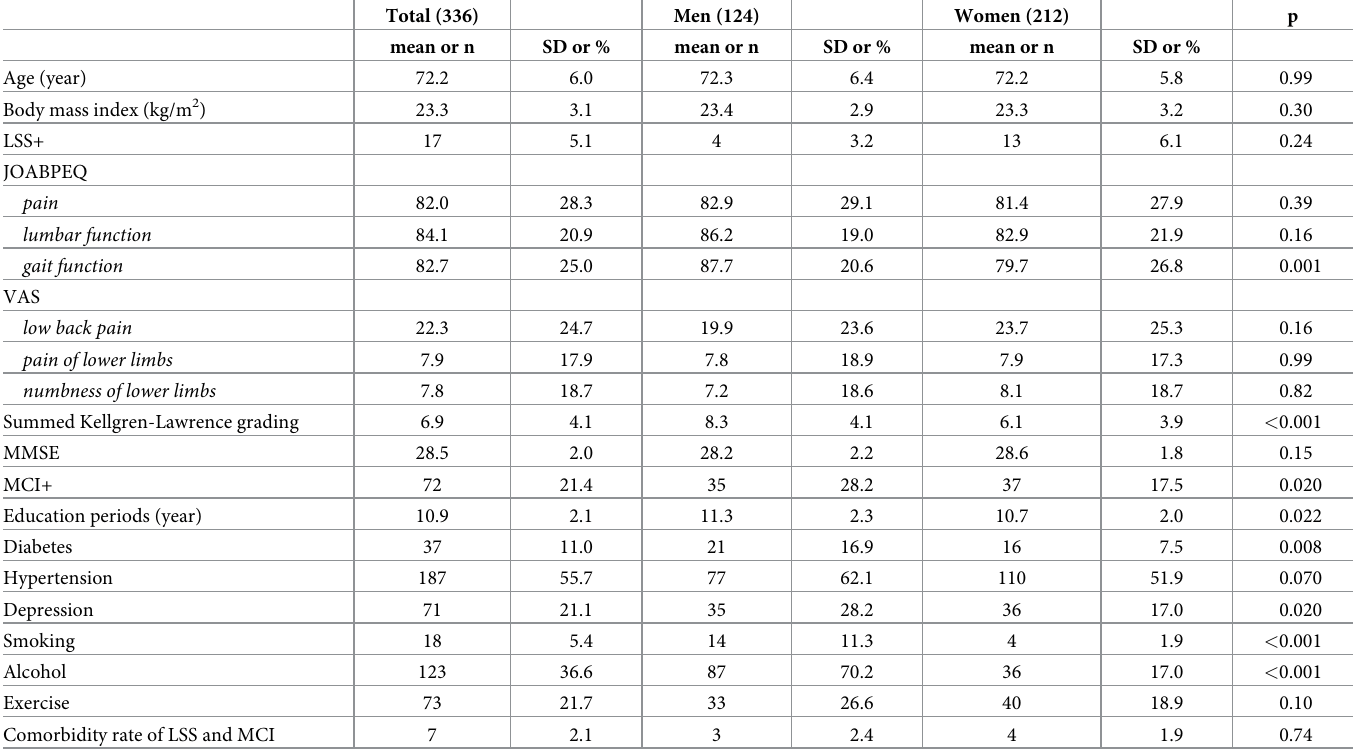
Table 1. Differences in MCI and LSS prevalence, JOABPEQ, VAS, medical histories, and daily habits with